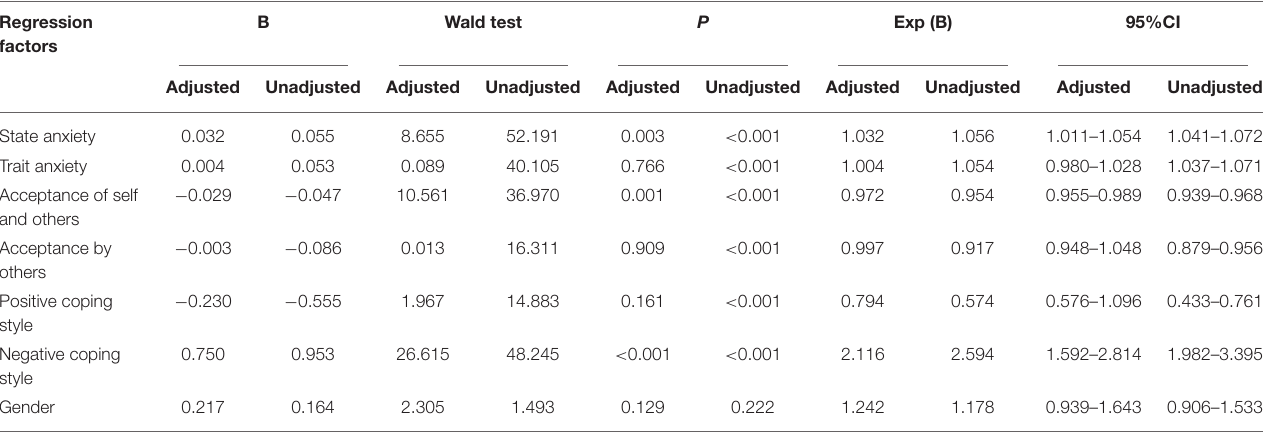
TABLE 3 | Factors related to Internet addiction ( n =